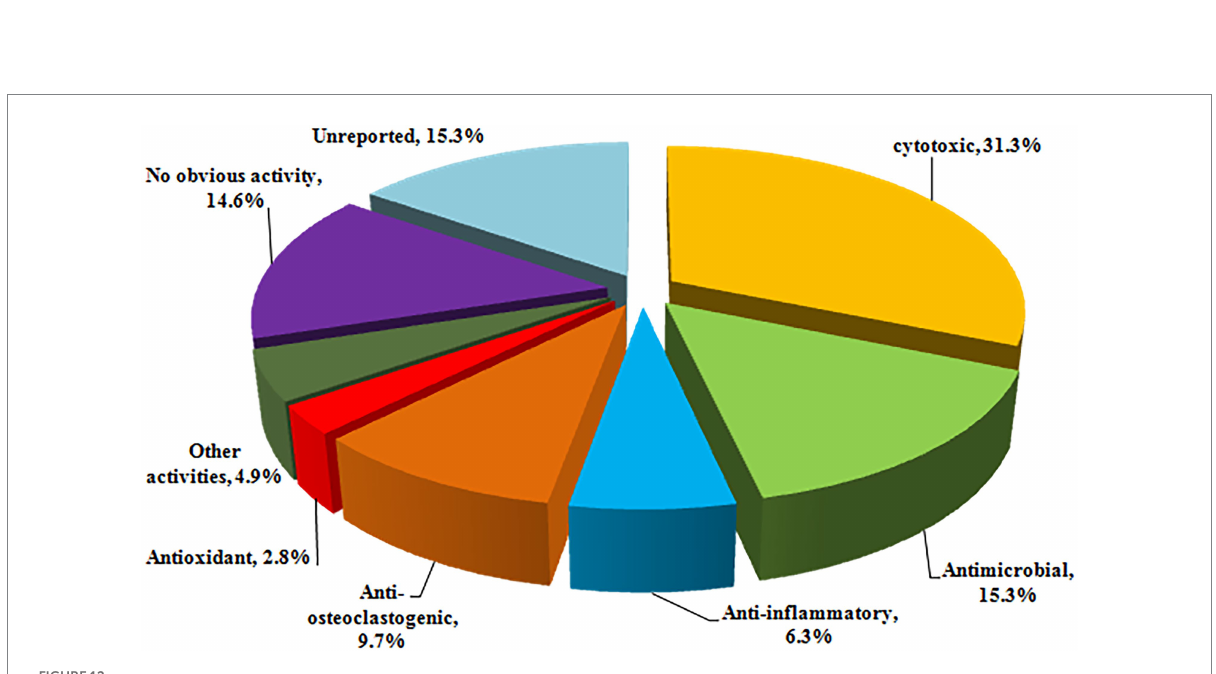
FIGURE 12 Percentages of bioactivities of halometabolites.